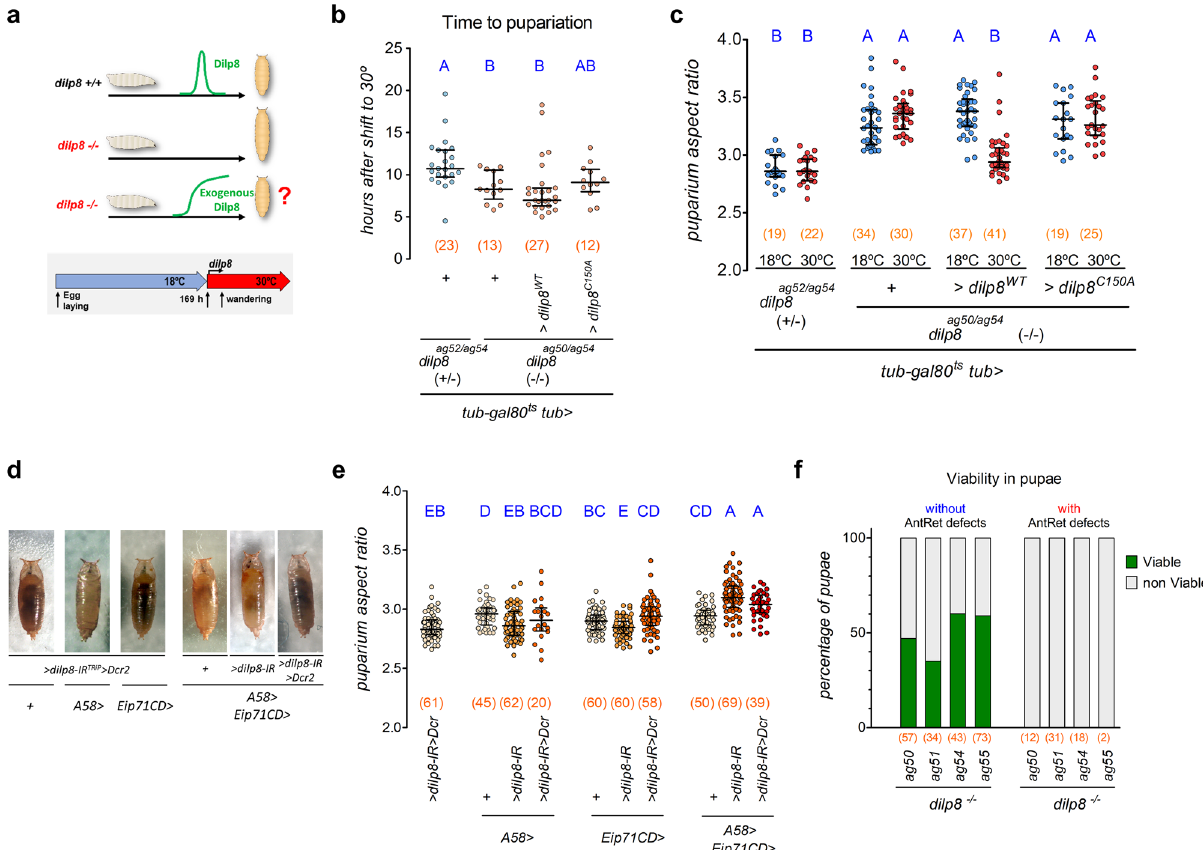
Fig. 3 dilp8 is required in the cuticle epidermis during pupariation for puparium morphogenesis and viability. a dilp8 temporal rescue scheme. b dilp8 expression after the midthird instar transition ( tub > dilp8 WT at 30 °C) does not delay pupariation time. Shown are dot plots of time to pupariation. c dilp8 expression after the midthird instar transition rescues the puparium aspect ratio (AR) of dilp8 mutants. Dot plots showing puparium AR. d Representative photos of puparia from the depicted genotypes. e Knockdown of dilp8 using combined epidermal drivers increases the aspect ratio of puparia. The same batch of A58 > / + and Eip71CD > / + control animals were used for Fig. 2f. Dot plots showing puparium AR. f Percentage of viable pupae (green) with and without anterior retraction (AntRet) defects. Failure in AntRet decreases pupal viability. Statistics (full details in Supplementary Table 2): b , c , e Dots: one animal. Horizontal bar, median. Error bars: 25-75% percentiles. b , c Dunn ’ s test. e Conover ’ s test. b , c , e Same blue letter, P > 0.05. (N) Number of animals